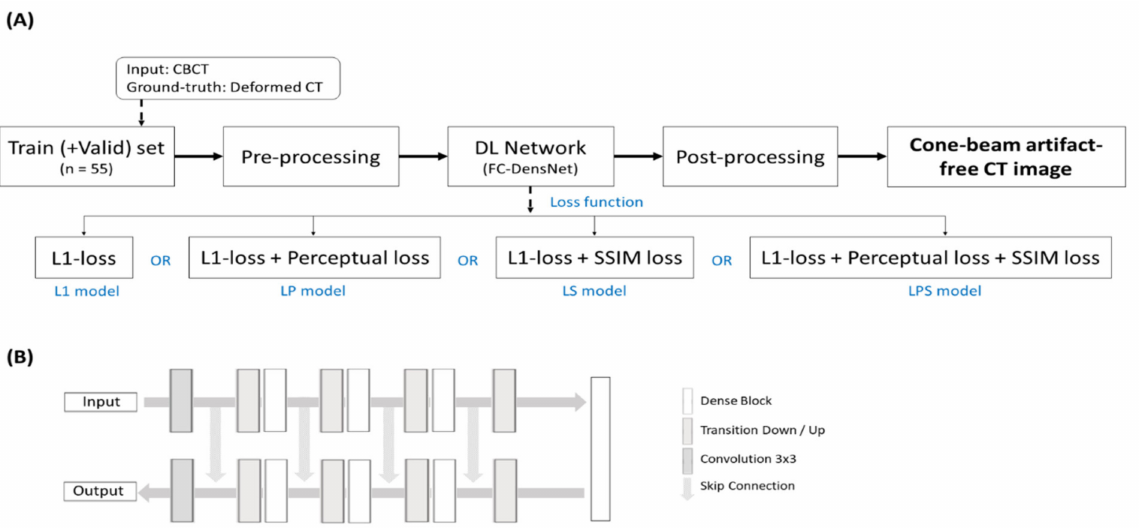
Figure 1. Study design of our study. ( A ) Flowchart of the compare four different learning losses and obtain a cone-beam artifact-free CT image trained with each loss. ( B ) FC-DenseNet is used as the DL architecture for the eliminate cone-beam artifact in